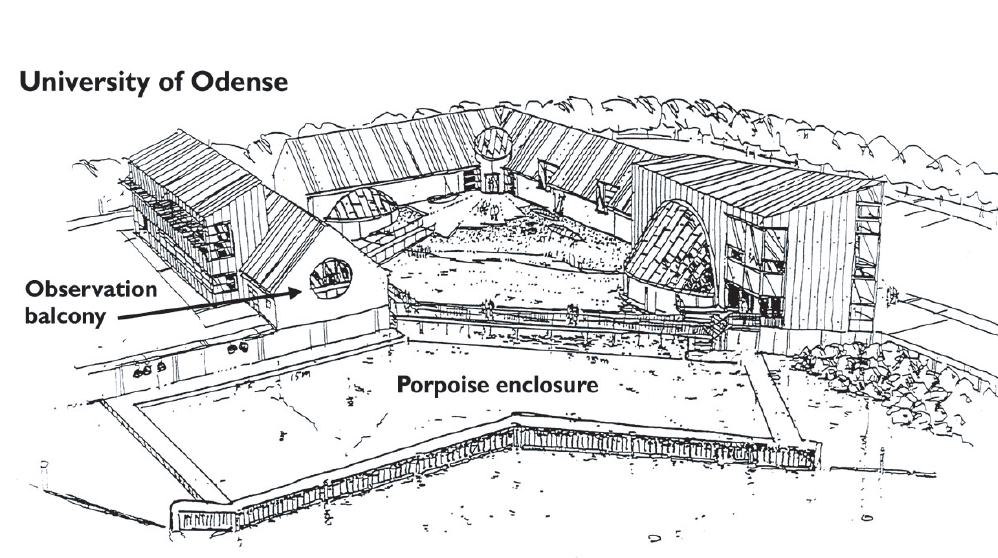
Fig. 1. Plan of the porpoise enclosure and general drawing of the Fjord&Bælt. The Centre for Aquatic Biology from the University of Southern Denmark can be seen on the left, with the bal- cony from which behavioural observations are